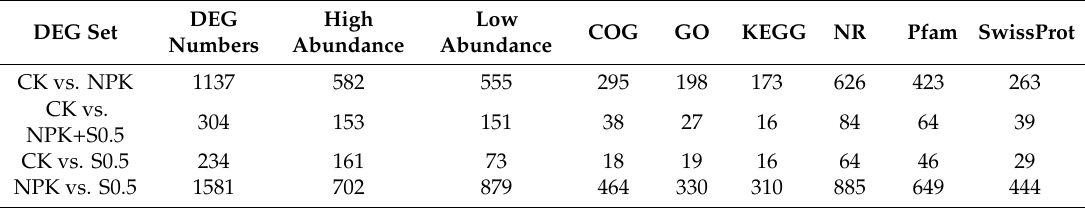
Table A2. Functional annotation of DEGs in the general